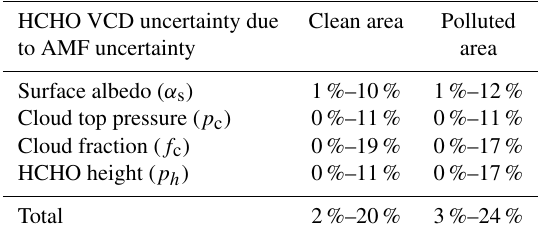
Table 2. Retrieval uncertainties of GEMS HCHO VCD due to AMF uncertainties as functions of surface albedos, cloud top pressures, cloud fractions, and HCHO profile heights for clean and polluted areas. Values are calculated for conditions with a solar zenith angle of 30 ◦ , a viewing zenith angle of 30 ◦ , a relative azimuth angle